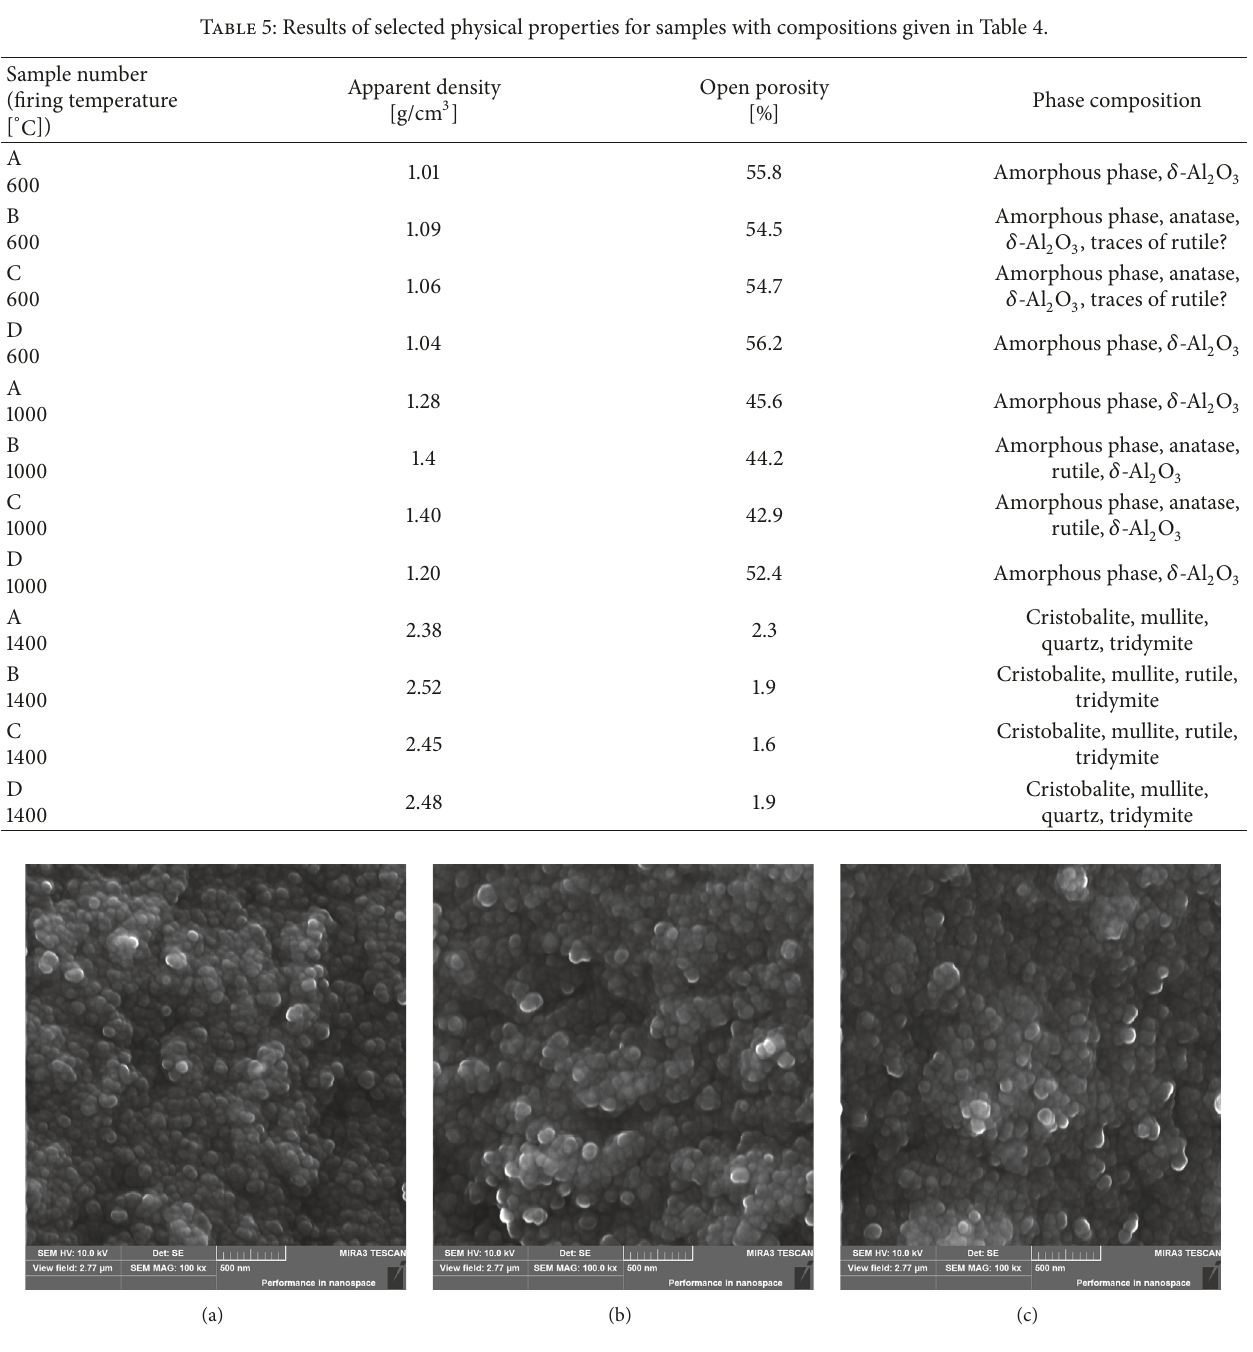
Figure 4: SEM micrographs for samples 1 (a), 4 (b), and 5